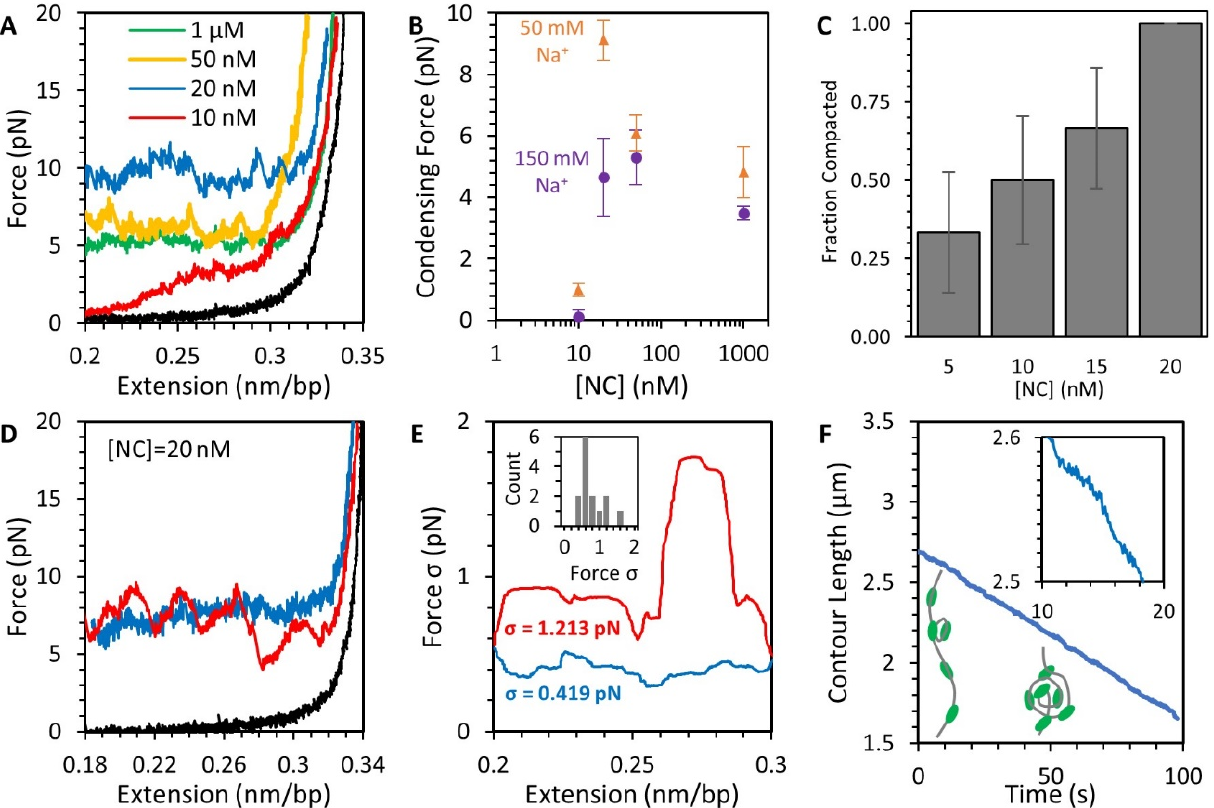
Figure 5. Compaction of DNA by NC at low force (Figure 3, step 3). ( A ) Decreasing the extension of the DNA substrate reduces its applied tension and allows for NC-mediated compaction depending on NC concentration (colored lines, black line shows protein-free DNA for reference). At saturating concentrations of NC (>20 nM), a force plateau emerges, where the NC condensate pulls against the stretching force and absorbs all excess DNA, preventing further drops in tension. At sub-saturating NC concentrations (10 nM), the DNA is not fully compacted and its tension approaches zero. ( B ) The average compaction force as a function of NC and Na + concentration shows a minimum of ~20 nM NC is needed for efficient compaction and a slight decrease in compaction force at higher protein concentration. ( C ) The fraction of DNA substrates that compact at low force (exhibit a force plateau) increases with NC concentration. ( D ) Individual force plateaus may appear rough or smooth as the force fluctuates moderately (blue) or substantially (red) as the DNA compacts. ( E ) The fluctuations in force, as measured by standard deviation of force ( σ ), are measured along the same force plateaus plotted in panel ( D ) using a moving average of 10 s. The rough plateau (red) shows greater deviations in force along its entire length as compared to the smooth plateau (blue) (average deviation over entire curves are listed on plot). The inset displays a histogram of individual DNA molecules compacted in the presence of NC. ( F ) Using instantaneous force and extension measurements, the contour length of the DNA-NC complex is calculated over time showing increasing DNA condensation as illustrated by inset cartoons. Instead of discrete steps, the length of the polymer decreases gradually as seen in the magnified inset. The instantaneous slope of this line varies over time, especially for DNA compactions with larger force deviations, but the contour length always decreases monotonically over time with an average rate determined by our instrument controls (i.e., the rate at which the beads are moved closer).